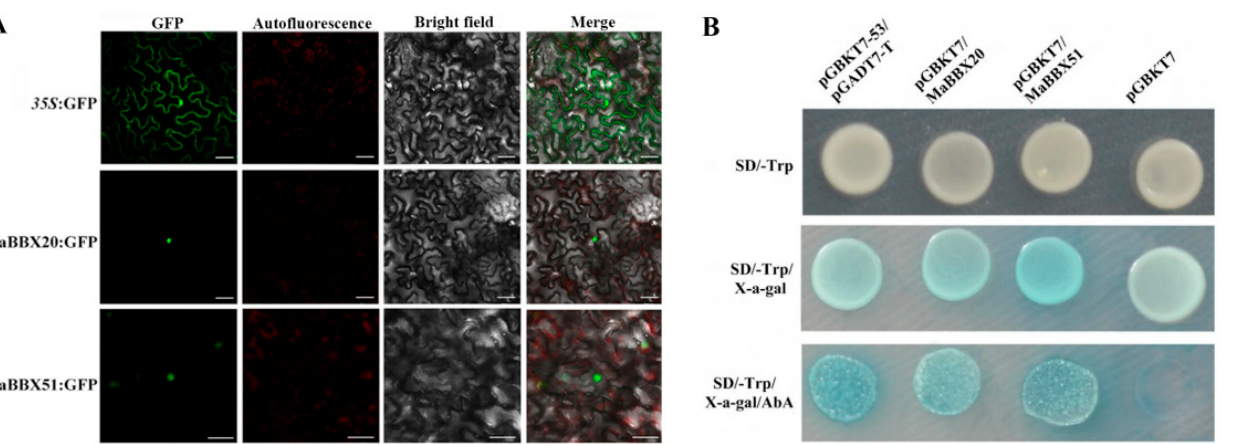
Figure 3. Subcellular localisation and transcription activation ability of MaBBX20 and MaBBX51. ( A ) After transient transformation of N. benthamiana leaves with 35S:GFP , 35S:MaBBX20:GFP , and 35S:MaBBX51:GFP , MaBBX20 and MaBBX51 were found localised in the nucleus. ( B ) Transcription activation ability of MaBBX20 and MaBBX51 in the yeast system.